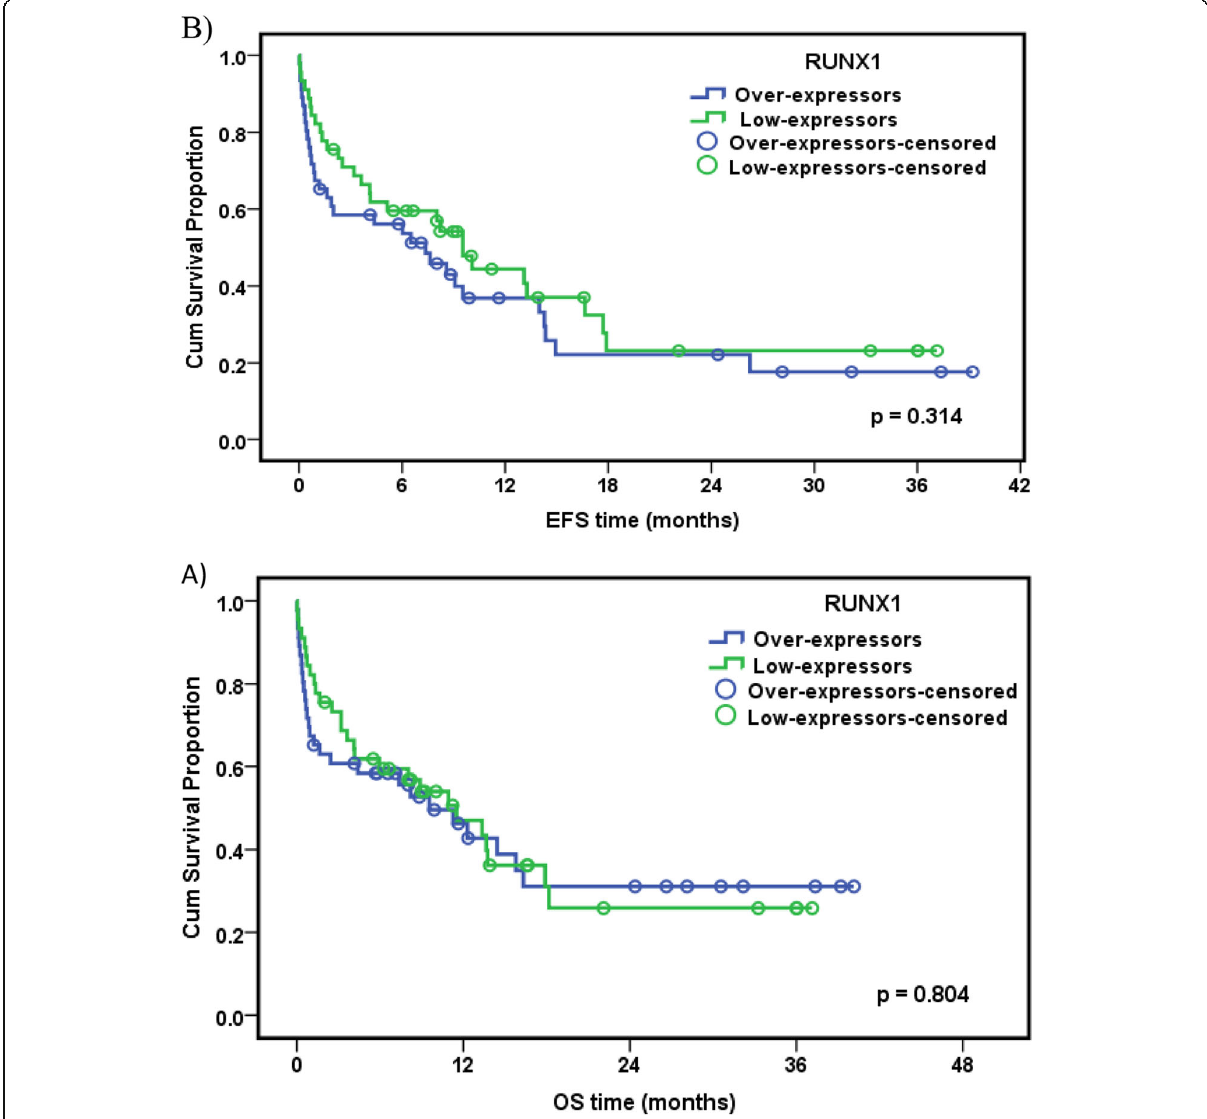
Fig. 3 a Overall survival and their relation to RUNX1 expression in the patients. b Event-free survival and their relation to RUNX1 expression in the